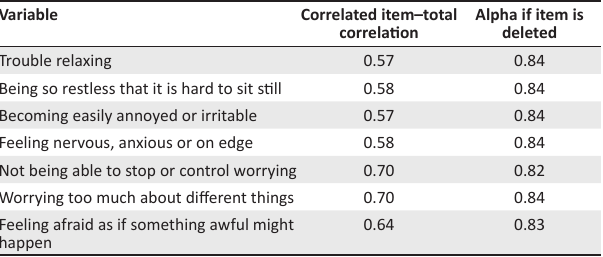
TABLE 5: Generalised anxiety disorder-7 scale item-level values and item–total correlations.